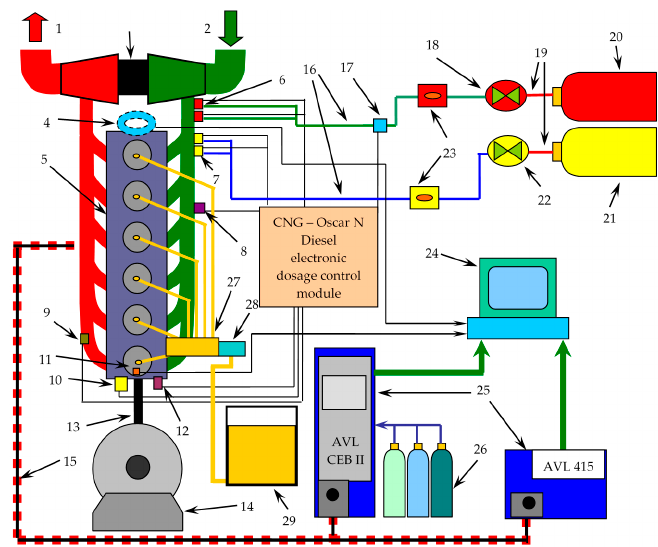
Figure 1. Scheme of the test bench with the Cummins 6T-590 engine adapted for dual fuel supply